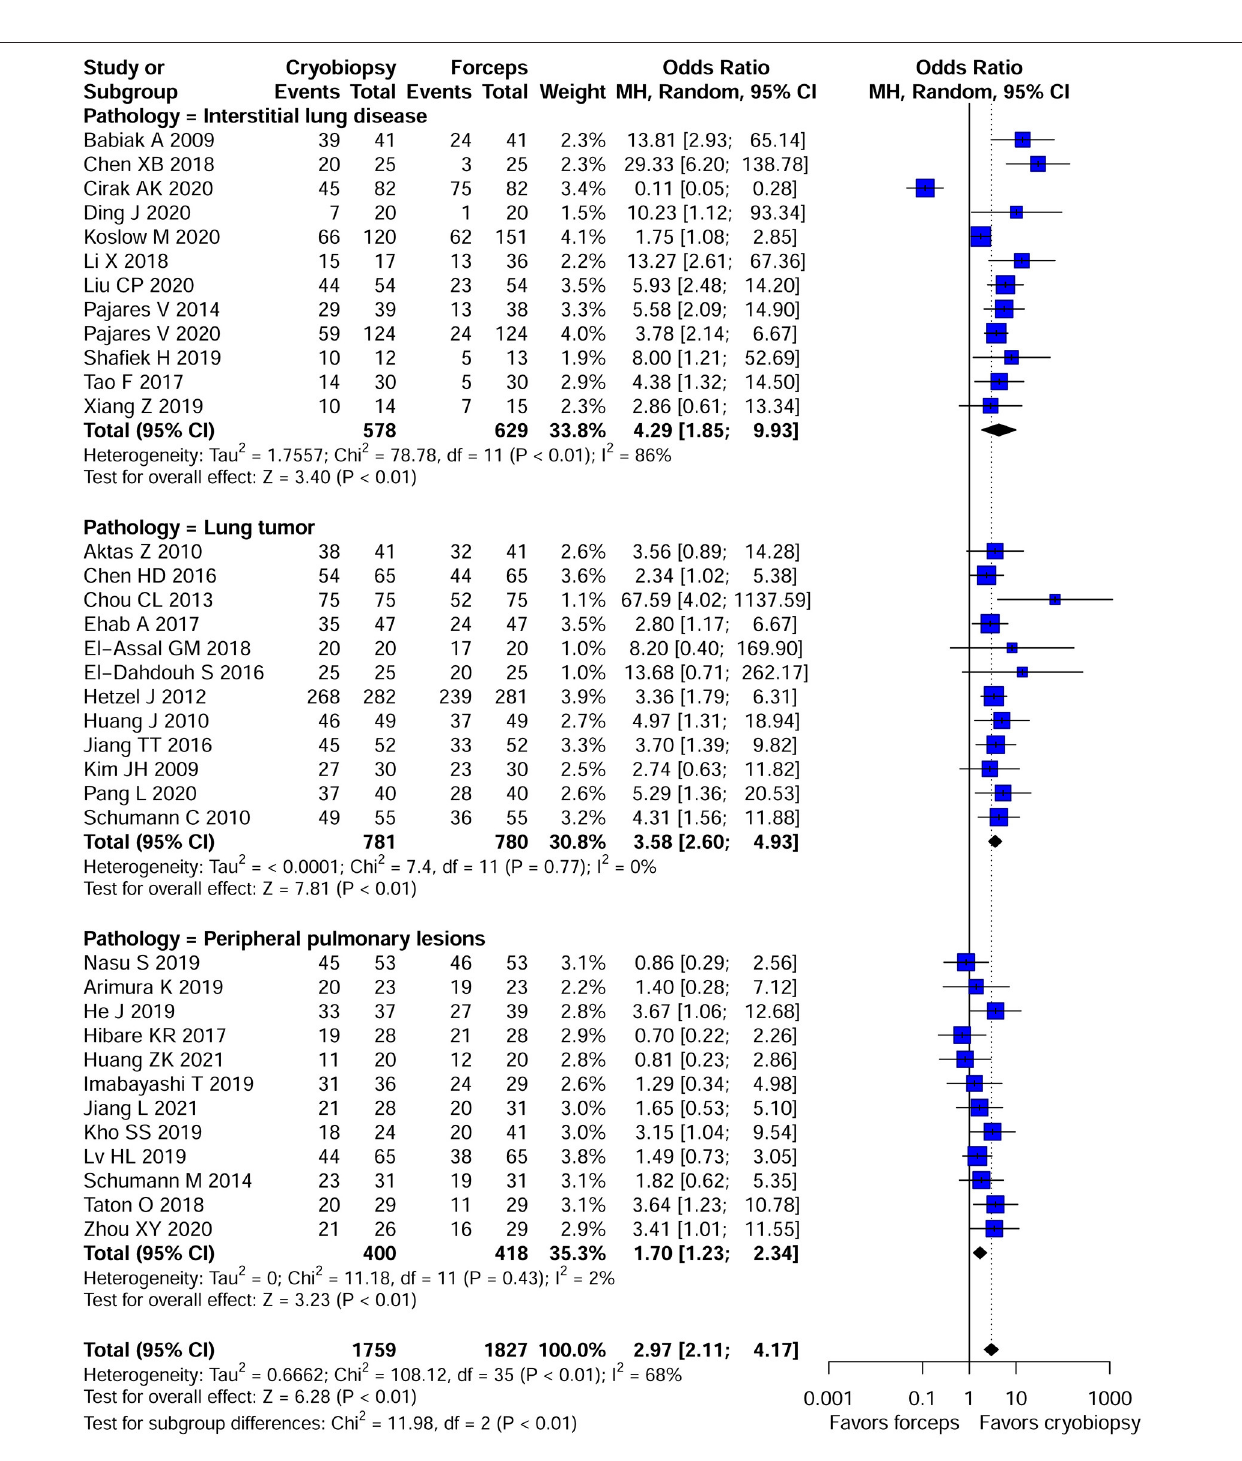
FIGURE 2 | Forest plot of diagnostic yield of cryobiopsy vs. forceps biopsy. Subgroup analysis showed that compared with forceps biopsy, cryobiopsy was associated with a significant increase in the diagnostic rates of interstitial lung diseases (ILDs) ( p < 0.01), lung tumors ( p < 0.01), and peripheral pulmonary lesions (PPLs) ( p < 0.01). CI, confidence